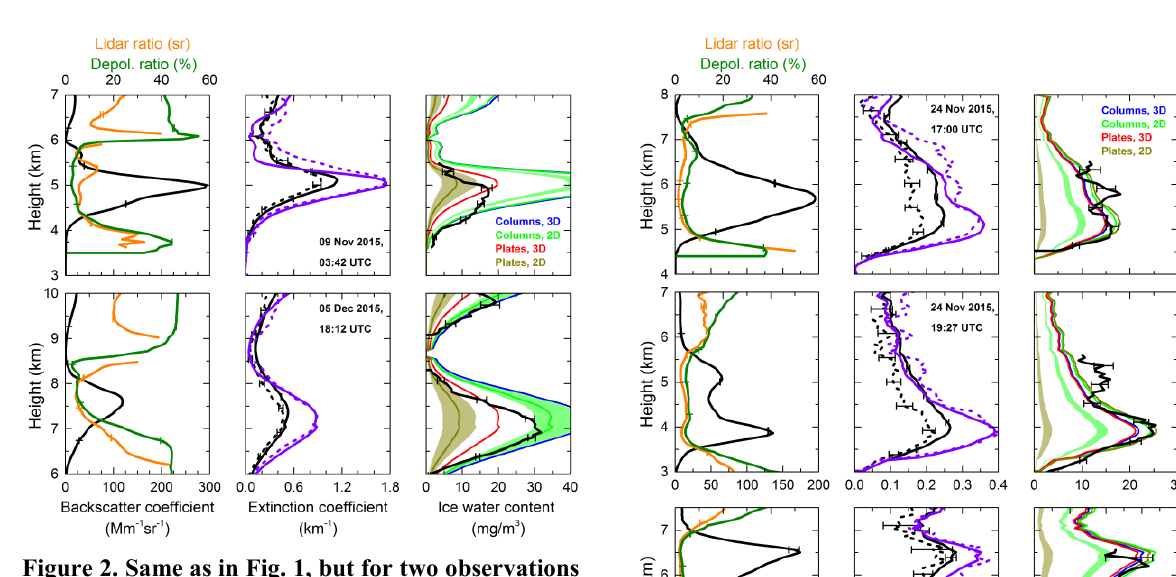
Figure 2. Same as in Fig. 1, but for two observations of 3D cirrus with embedded 2D layer of low ice water content. Either 3D, or 2D, plates or columns are assumed, aspect ratios are 0.06 and 1.5 (top), and 0.08 and 3.0 (bottom), respectively.